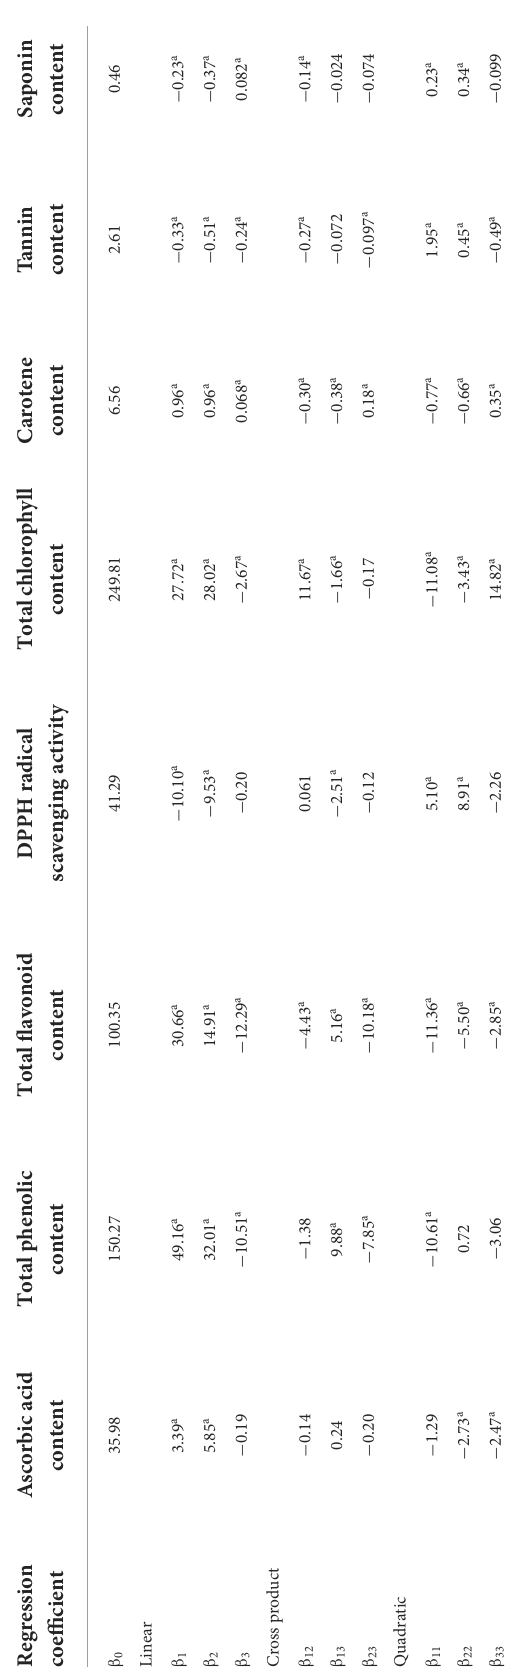
Table 3 shows a significant effect of all linear and quadratic terms of AV, AT, and MWP on the total chlorophyll content